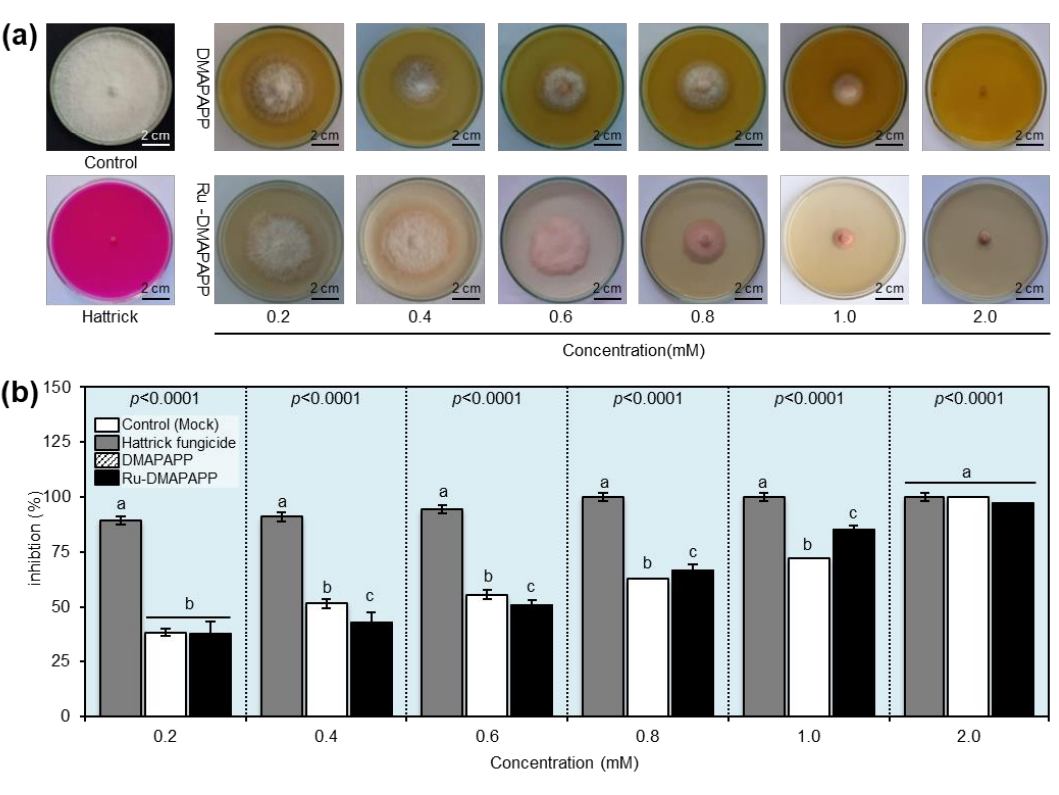
Figure 3. In vitro antifungal activity of two bis-chalcone derivatives, DMAPAPP and Ru-DMAPAPP, against Fusarium equiseti . ( a ) Antifungal activity of DMAPAPP and Ru-DMAPAPP against F. equiseti . ( b ) Inhibition (%) of mycelial radial growth of F. equiseti after treatment with different concentrations (0.2, 0.4, 0.6, 0.8, 1.0, and 2.0 mM) of DMAPAPP and Ru-DMAPAPP. Values represent the means ± standard deviations (mean ± SD). Different letters indicate statistically significant differences between treatments using the Tukey–Kramer honestly significant difference test (Tukey HSD; p < 0.05).